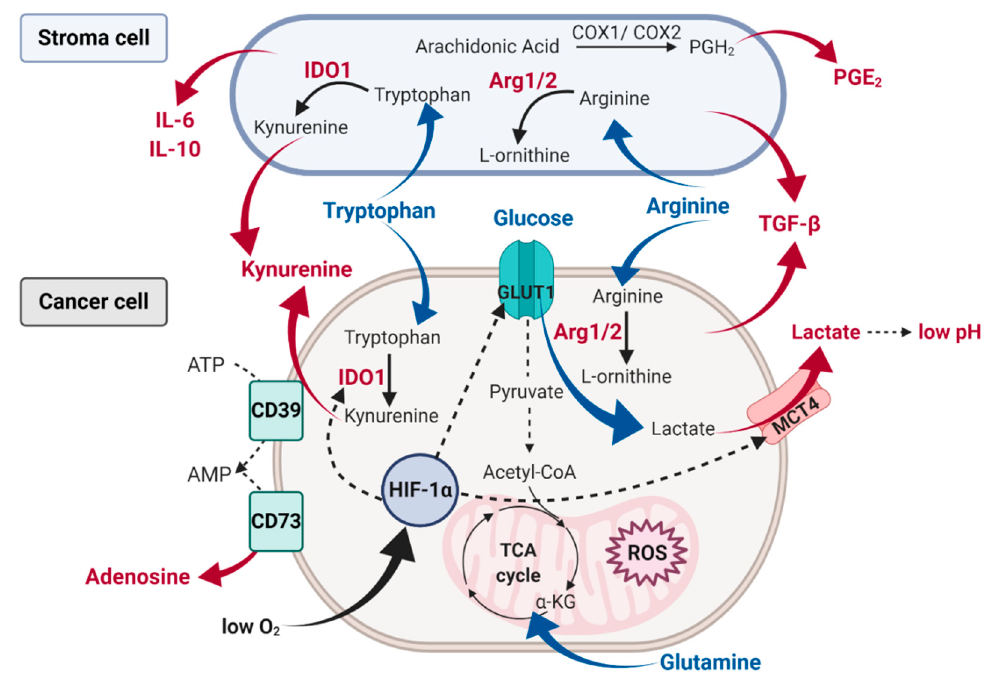
Figure 2. A schematic characteristic of the tumor microenvironment metabolites and other factors impacting NK cell effector function. Within the tumor microenvironment cancer cells consume large amounts of glucose and produce lactate and subsequent extracellular acidosis. Glycolytic conversion of glucose into pyruvate also stimulates the production of ROS. Tumor cells, as well as stromal cells, compete for nutrients such as glucose, glutamine, and amino acids. Thus, cancer cells together with stroma cells increase amino acids consumption and upregulate key amino acid metabolism enzymes, such as IDO and Arg1/2, leading to the accumulation of amino acids’ immunosuppressive metabolites, such as kynurenine. Tumor cells also generate extracellular adenosine through the ectonucleotidases CD39 and CD73. Moreover, high oxygen consumption by tumor cells can cause hypoxic conditions, which sustains HIF-1 α , which in turn promotes glycolytic metabolism by upregulation of GLUT1 and lactate production by modulation of lactate transporters expression. Moreover, tumor and tumor-associated cells secrete factors, which prevent NK cell activation, such as TGF- β , IL-6, IL-10, and PGE 2 .